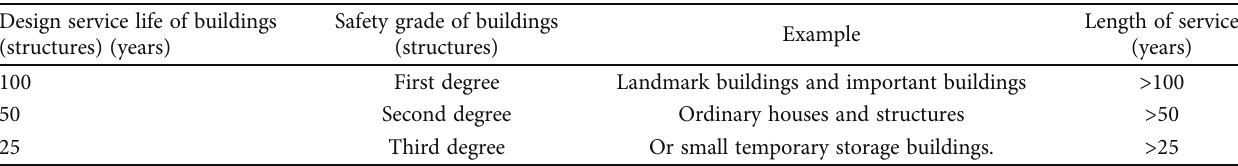
Table 8: Reasonable service life of slope engineering.